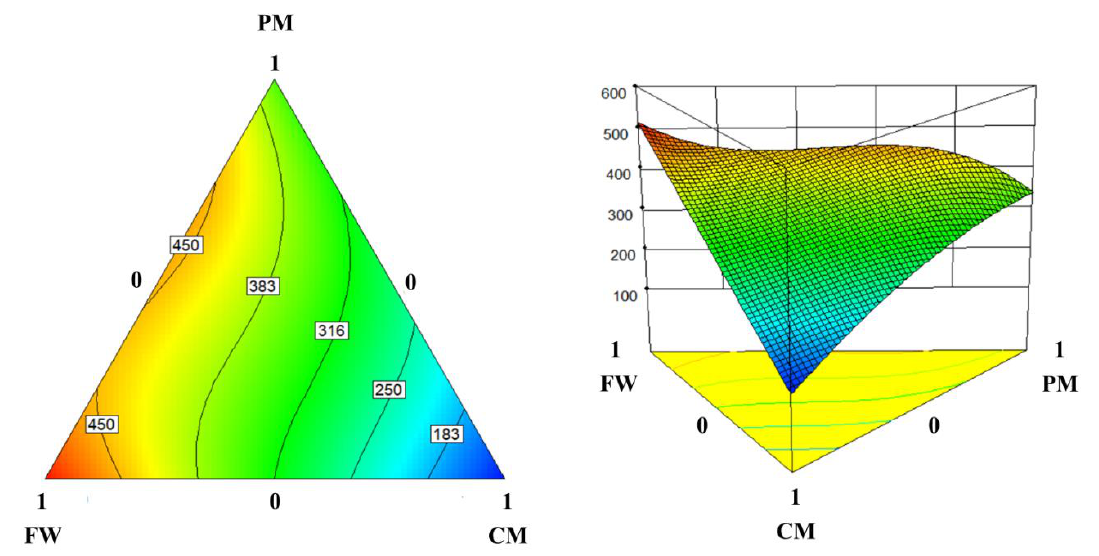
Figure 3. Two- and three-dimensional response surface plots illustrating the effect of the substrate mixing ratio on the 30-day methane yield. Contour colors represent the levels of model response: blue for low and red for high responses.